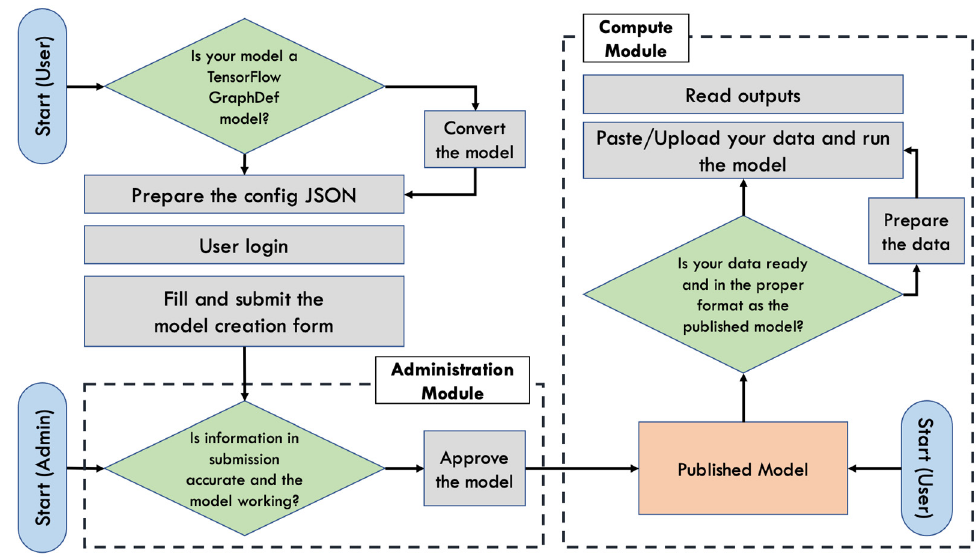
Figure 5. Model creation/submission and computing workflow.